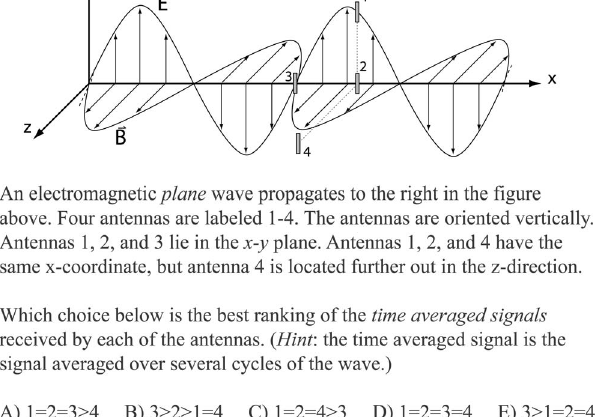
FIG. 8. EM wave concept question. Correct answer is (cid:1) D (cid:2)